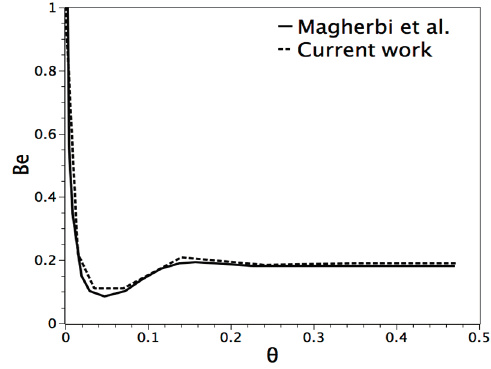
Figure 6. Bejan number (Be) vs. dimensionless time θ